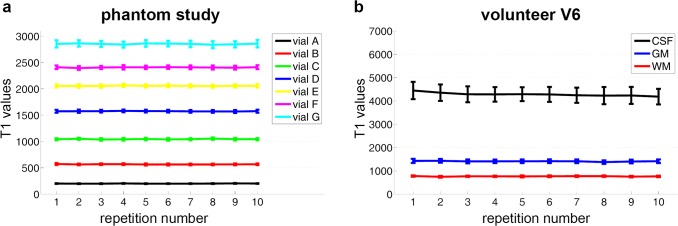
Reproducibility study.Shown are the mean T1 values obtained from IR-MAP reconstructions of ten consecutive IR-LL acquisitions, each of which was followed by a 15 second break for relaxation. While a) shows the results in the seven ROIs of the phantom (A-G), b) depicts the ROIs used for evaluation of T1 in WM, GM and CSF of volunteer V7.